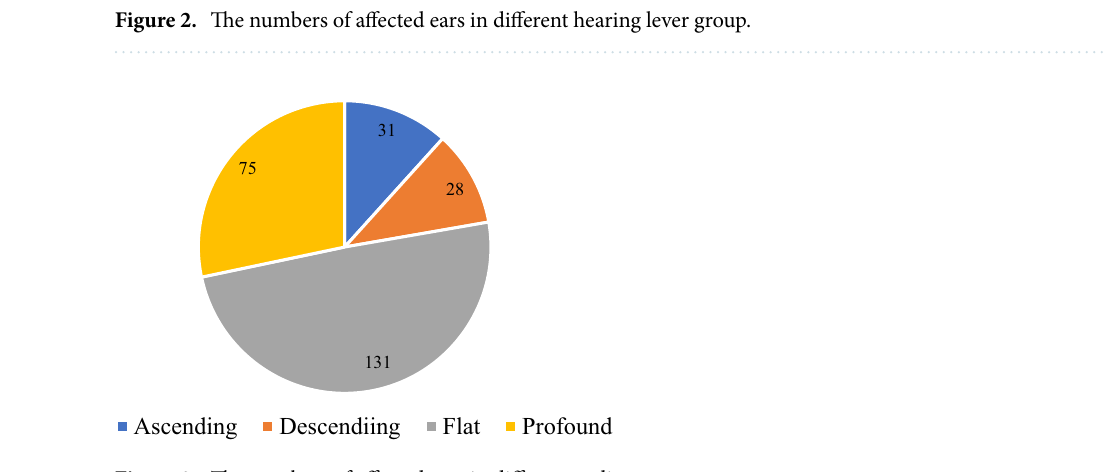
Figure 3. The numbers of affected ears in different audiogram type group.